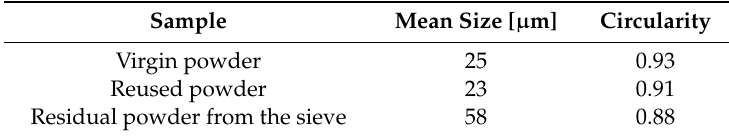
Table 2. Summary table from the measurement of the particle size distribution and circularity for di ff erent samples.